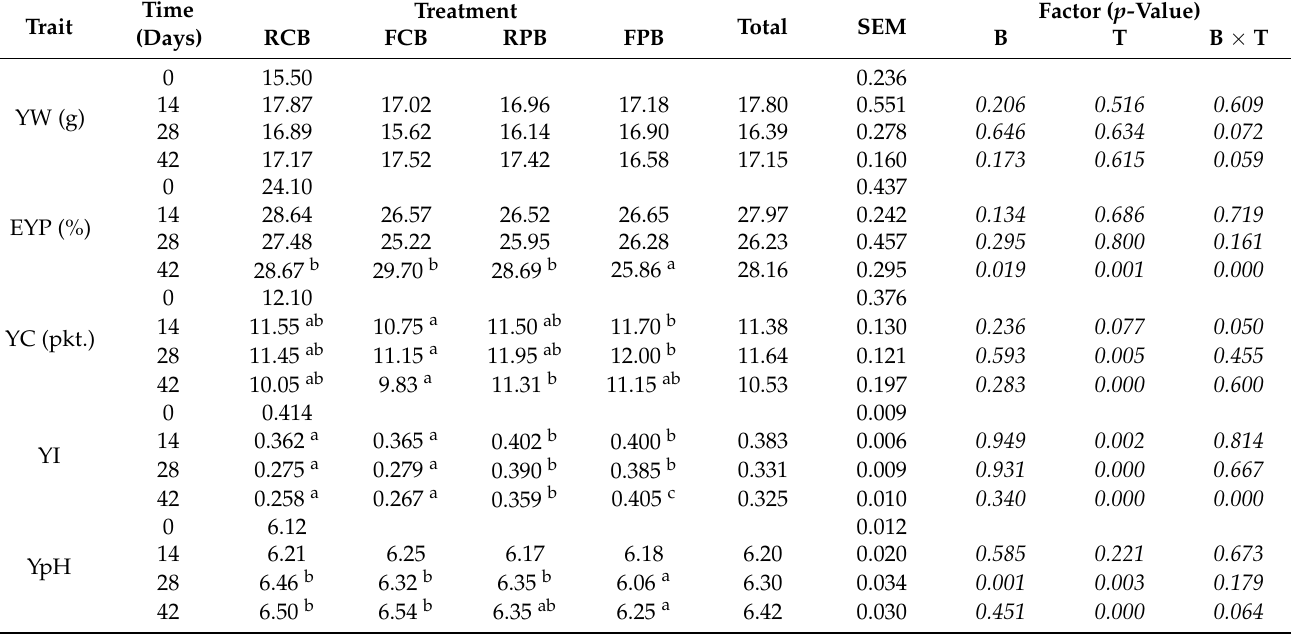
Table 4. Changes in the characteristics of yolk depending on packaging and storage